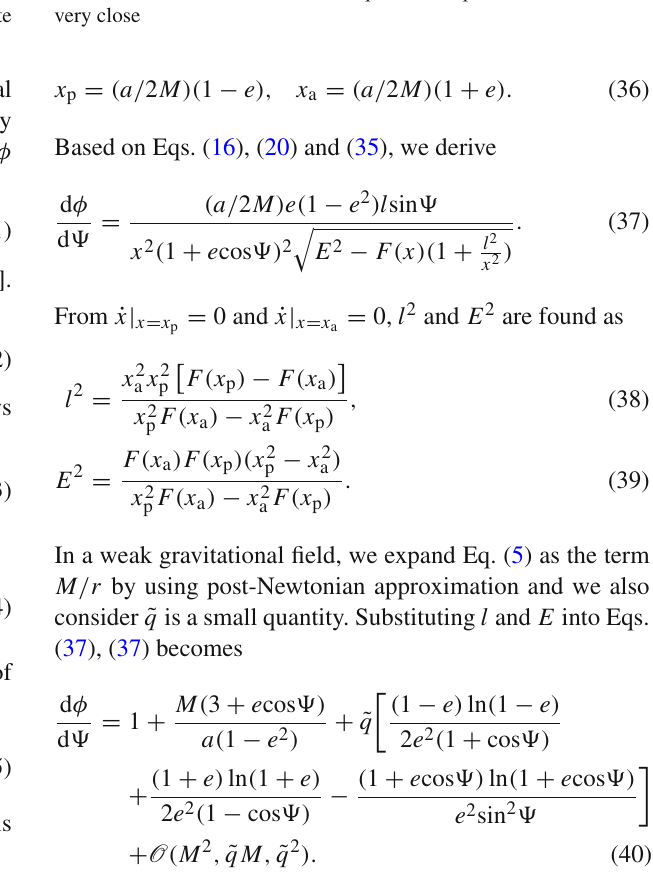
Fig. 5 The ( l , E ) allowed region of the bound orbits around the hairy black hole with fixed values ˜ q . The upper and lower curves in each shadow region represent respectively the upper and lower bounds. Note